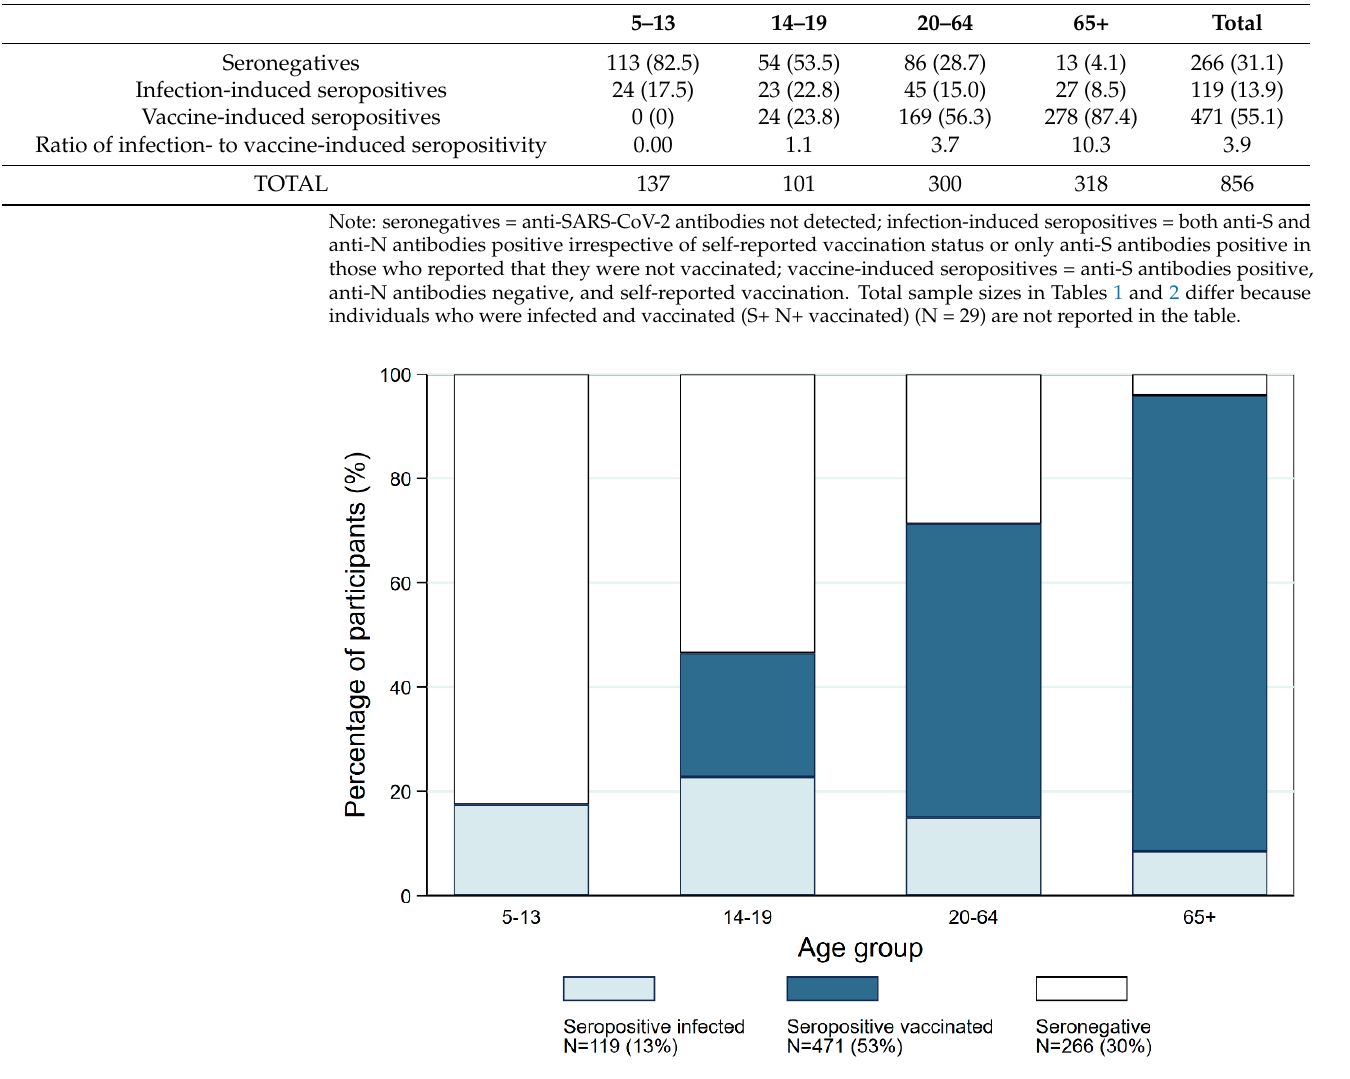
Figure 4. Rates of infection- and vaccine-induced immunity by age group at the third serosurvey in June 2021 (N = 885). Seronegatives = anti-SARS-CoV-2 antibodies not detected; infection-induced seropositives = both anti-S and anti-N antibodies positive irrespective of self-reported vaccination status or only anti-S antibodies positive in those who reported that they were not vaccinated; vaccine-induced seropositives = anti-S antibodies positive, anti-N antibodies negative, and self-reported vaccination. Individuals who were infected and vaccinated (S+ N+ vaccinated) (N = 29) are not reported.